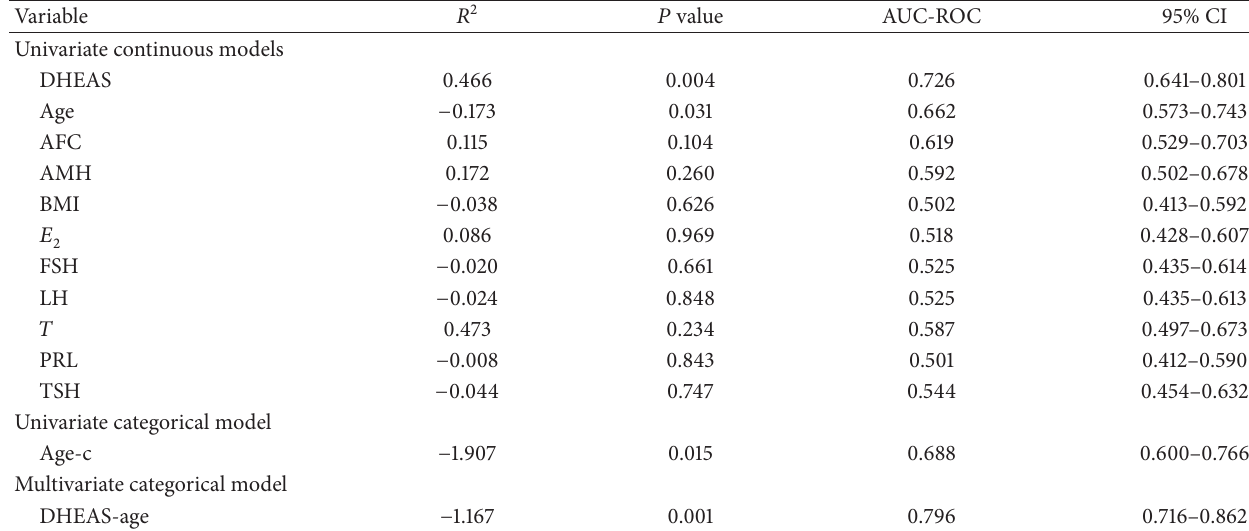
Table 2: Univariate and multivariate logistic regression analysis of variables studied for the prediction of clinical pregnancy in patients with low AMH and area under the receiver operating characteristic curves (AUC-ROC)